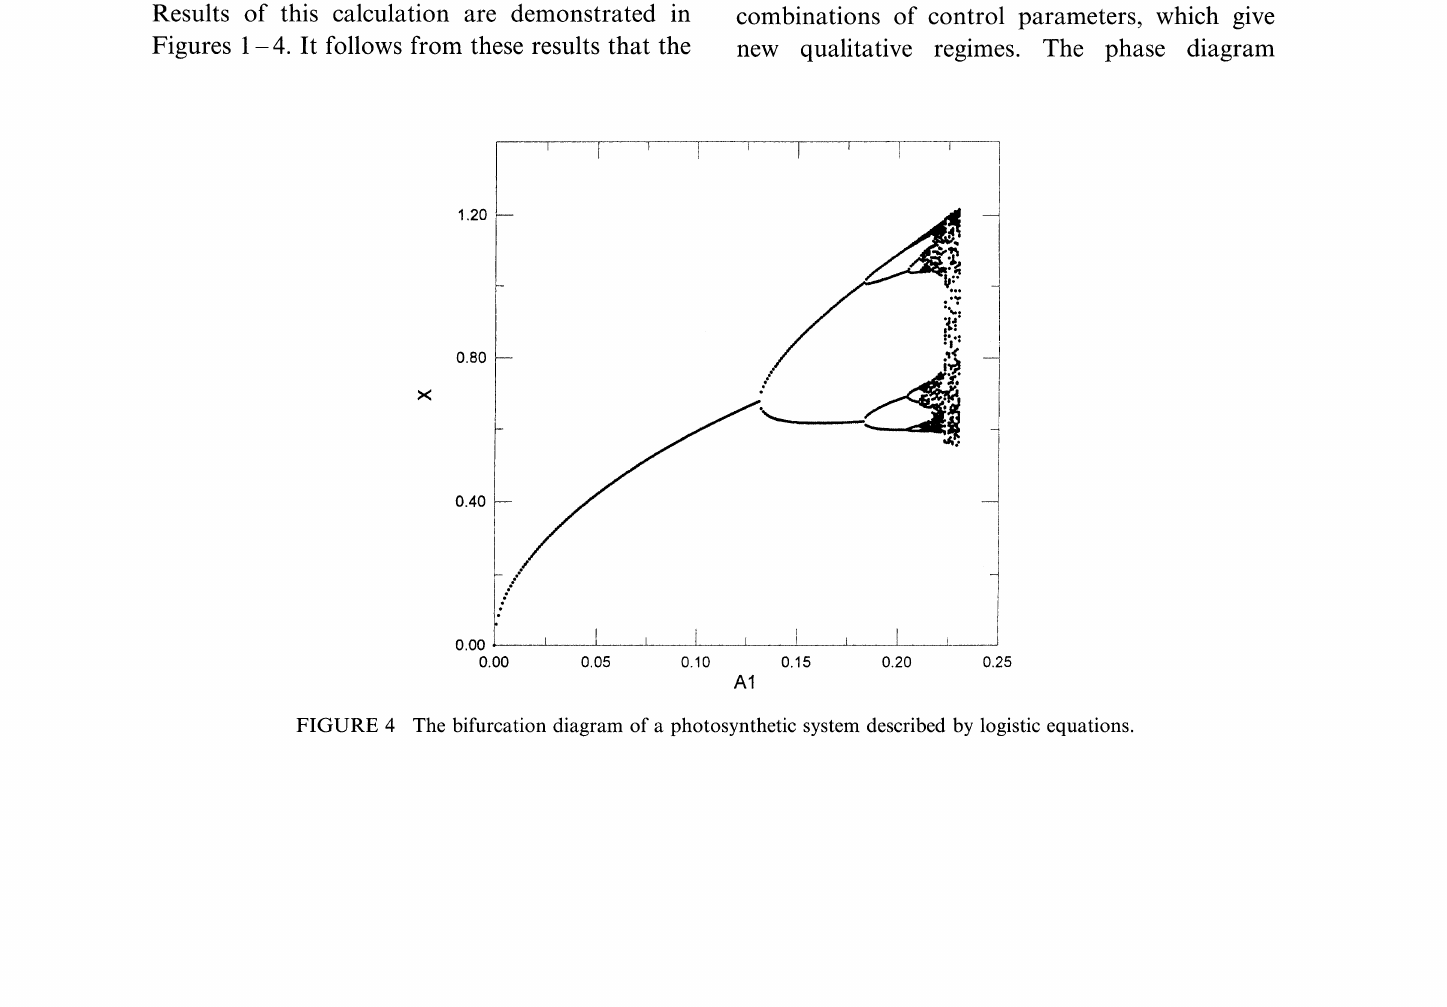
interval (0;0.231) and the calculation was per- formed at the starting point X0-0 and Y0-0.2.